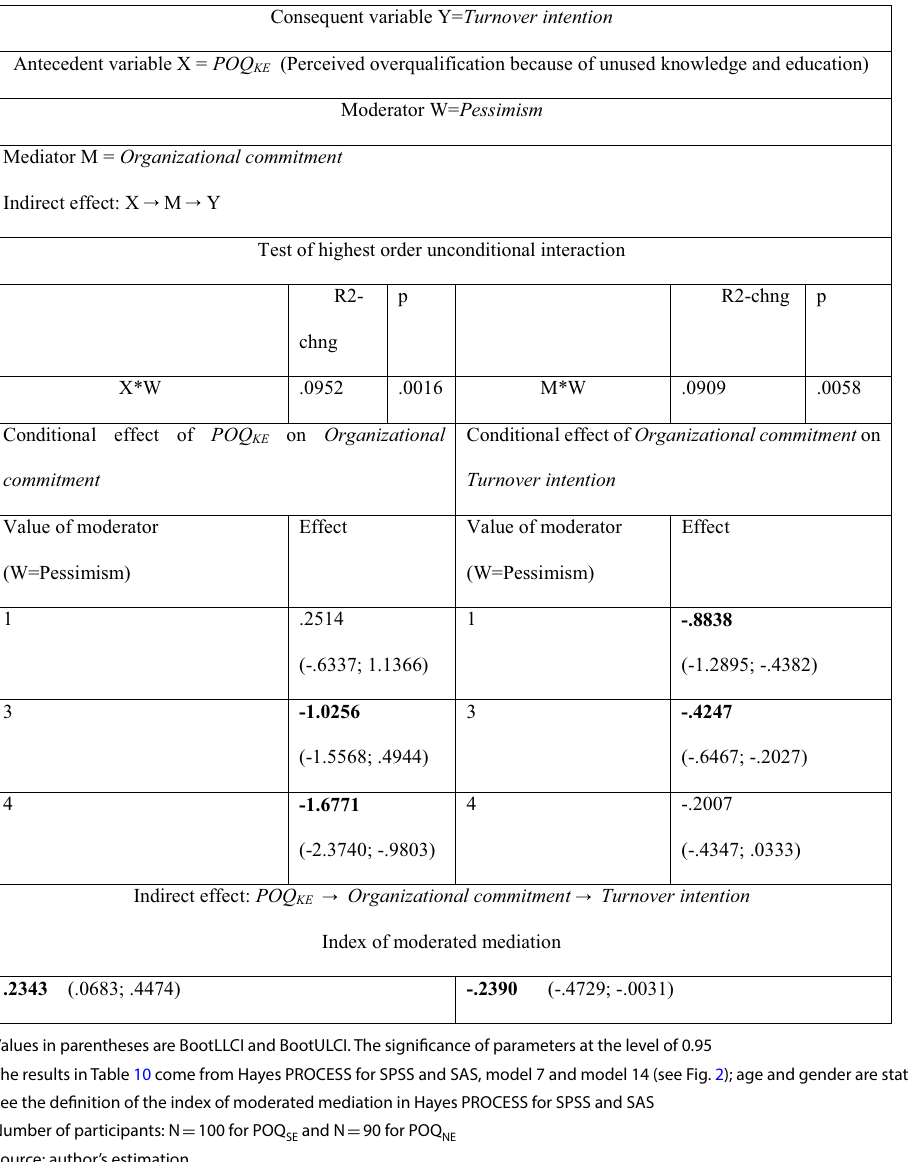
Table 10 Moderated mediation effect of POQ Turnover intention ; Pessimism as a